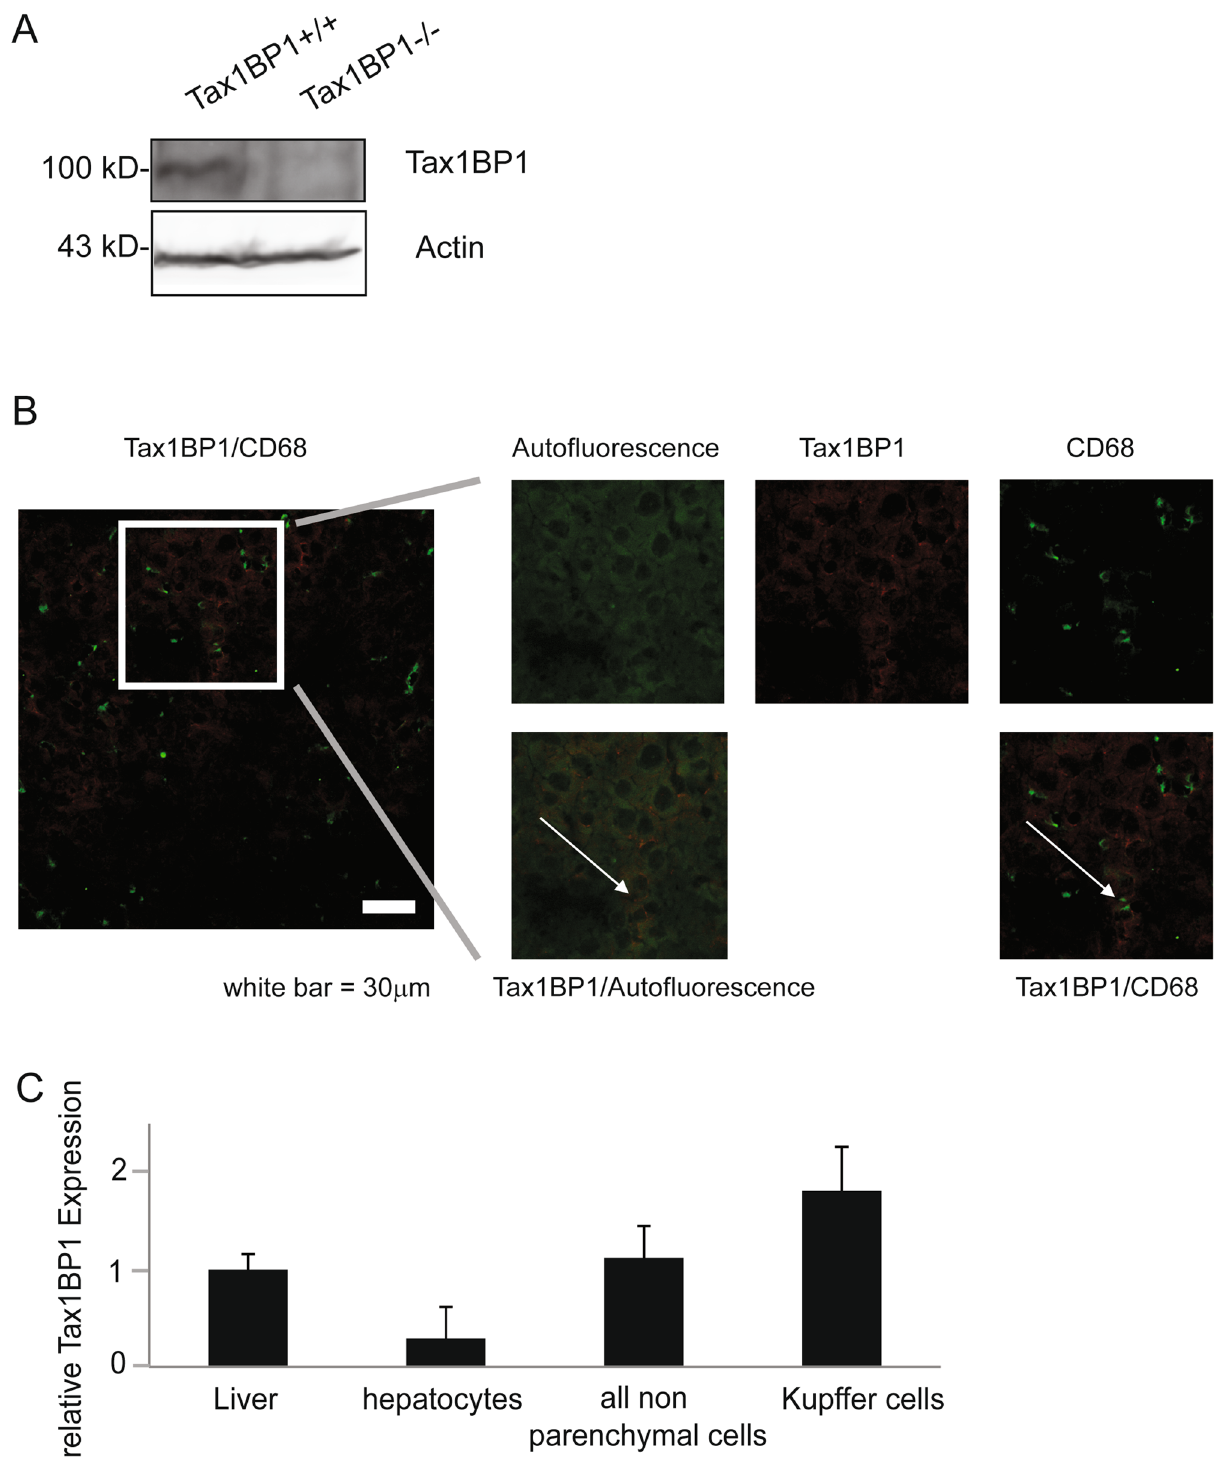
Figure 1. Tax1BP1 expression in different hepatic compartments. Tax1BP1 expression was determined in liver lysates of Tax1BP1 +/+ and Tax1BP1 −/− mice by Western Blotting using a polyclonal antibody ( A ). Confocal laser scanning microscopy showing hepatocytes´ autofluorescence (green), Tax1BP1 (red), and CD68 (green) (magnification × 400). Arrows in the cutouts show representative areas of colocalization of the indicated stainings, respectively ( B ). Quantitative PCR was performed to assess relative Tax1BP1 mRNA expression, normalized to GPDH, in whole liver, hepatocytes, all non-parenchymal cells and Kupffer cells. Relative Tax1BP1 expression is shown in relation to whole liver ( C